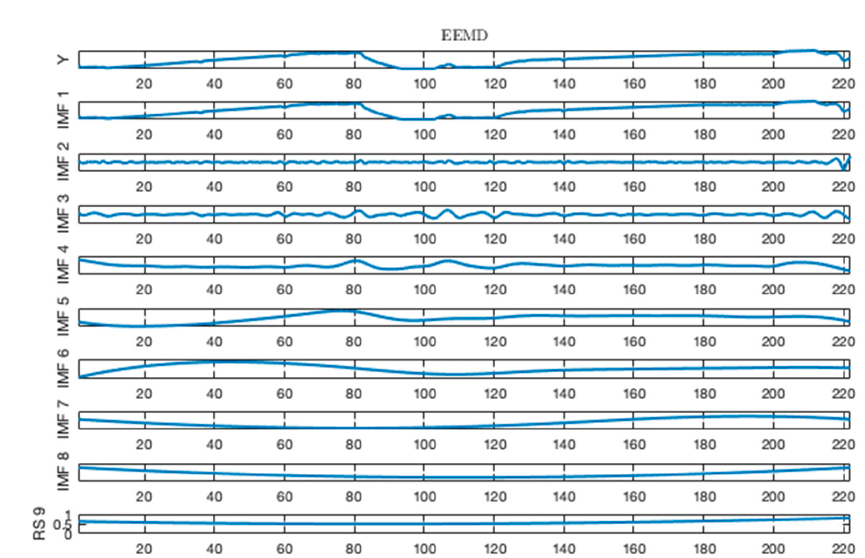
Figure 17. EEMD decomposition of “front flat line 95.”